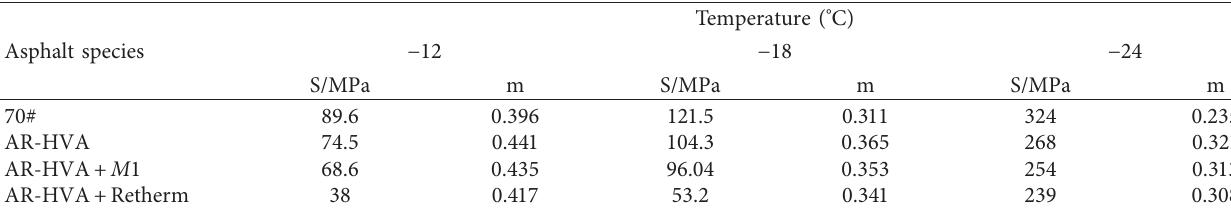
Table 3: Results of creep test of bending beam